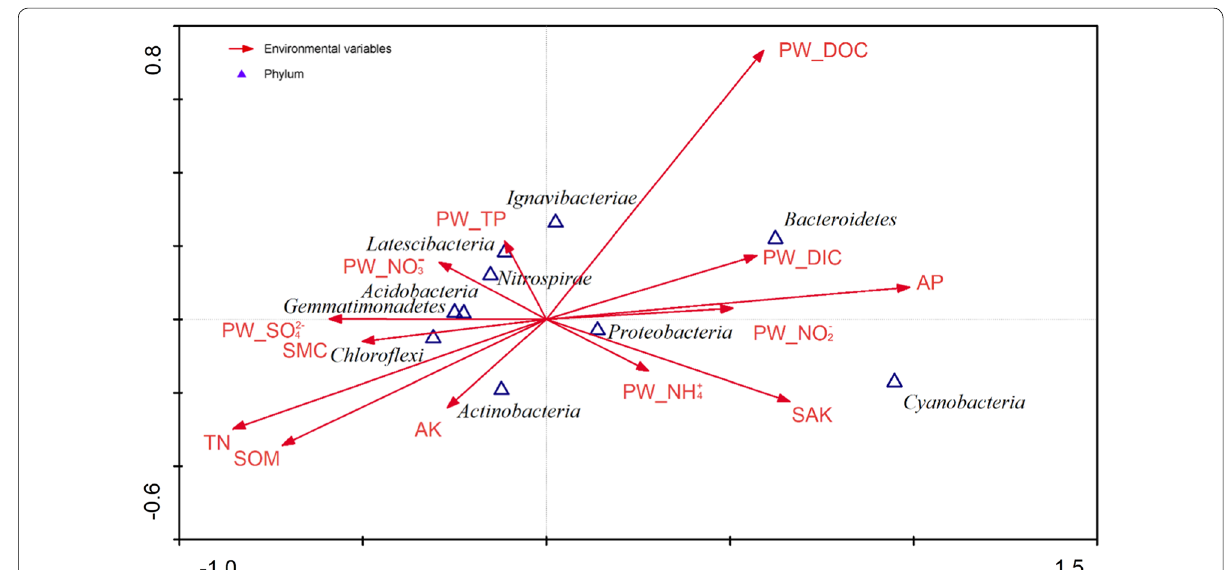
Fig. 5 Biplot of ten bacteria of relatively high abundance (in phylum level) and 13 corresponding environmental variables in CCA ordination of rice paddy soil. Biplot vectors shown represent the major explanatory environmental variables. SMC soil moisture content, TN soil total nitrogen, SOM soil organic matter, AP soil available phosphorus, AK available potassium, SAK slowly available potassium, PW_DOC pore water dissolved organic carbon, PW_DIC pore water dissolved inorganic carbon, PW _ SO 2 − 4 pore water sulfate, PW _ NO − 3 pore water nitrate, PW _ NO − 2 pore water nitrite,